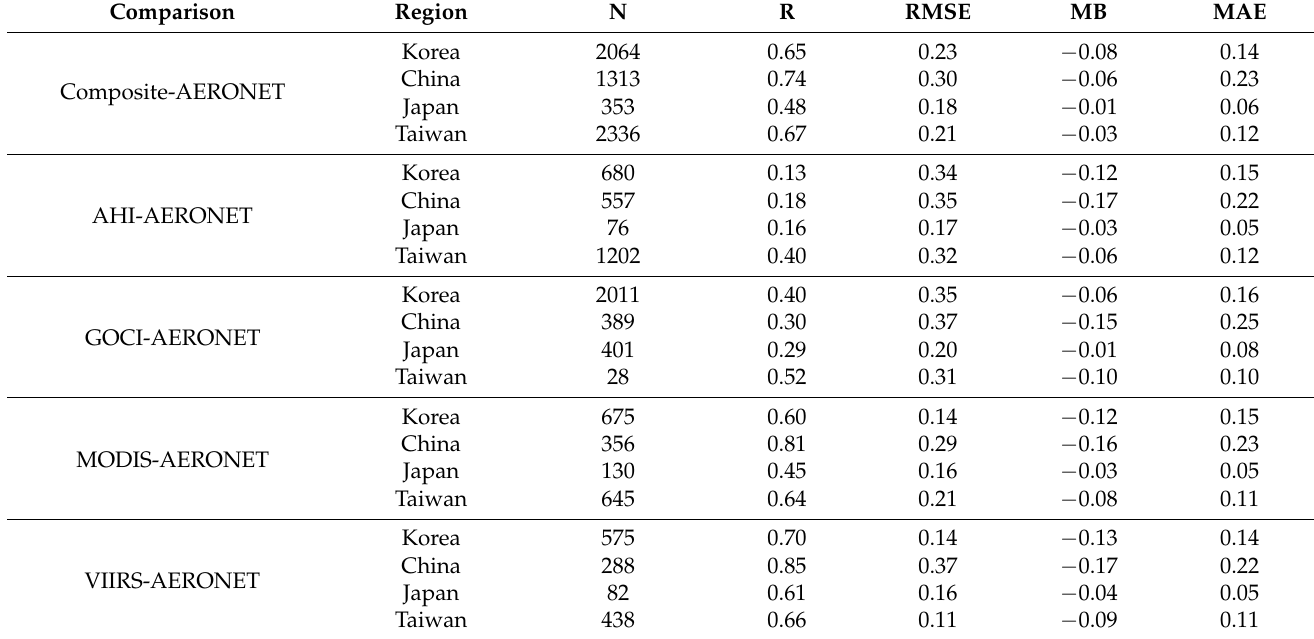
Table A6. Spatial comparison statistics for composite, satellites, and AEORNET AOD products at 500 nm from January to December